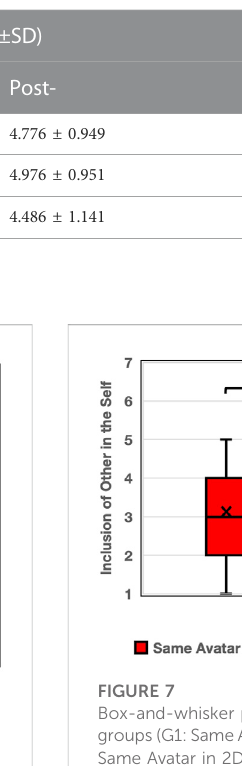
TABLE 2 Degrees of Agreement with Opinions introduced by the avatar before and after the role-play (G1: Same Avatar in IVR; G2: Different Avatar in IVR; G3: Same Avatar in 2D).